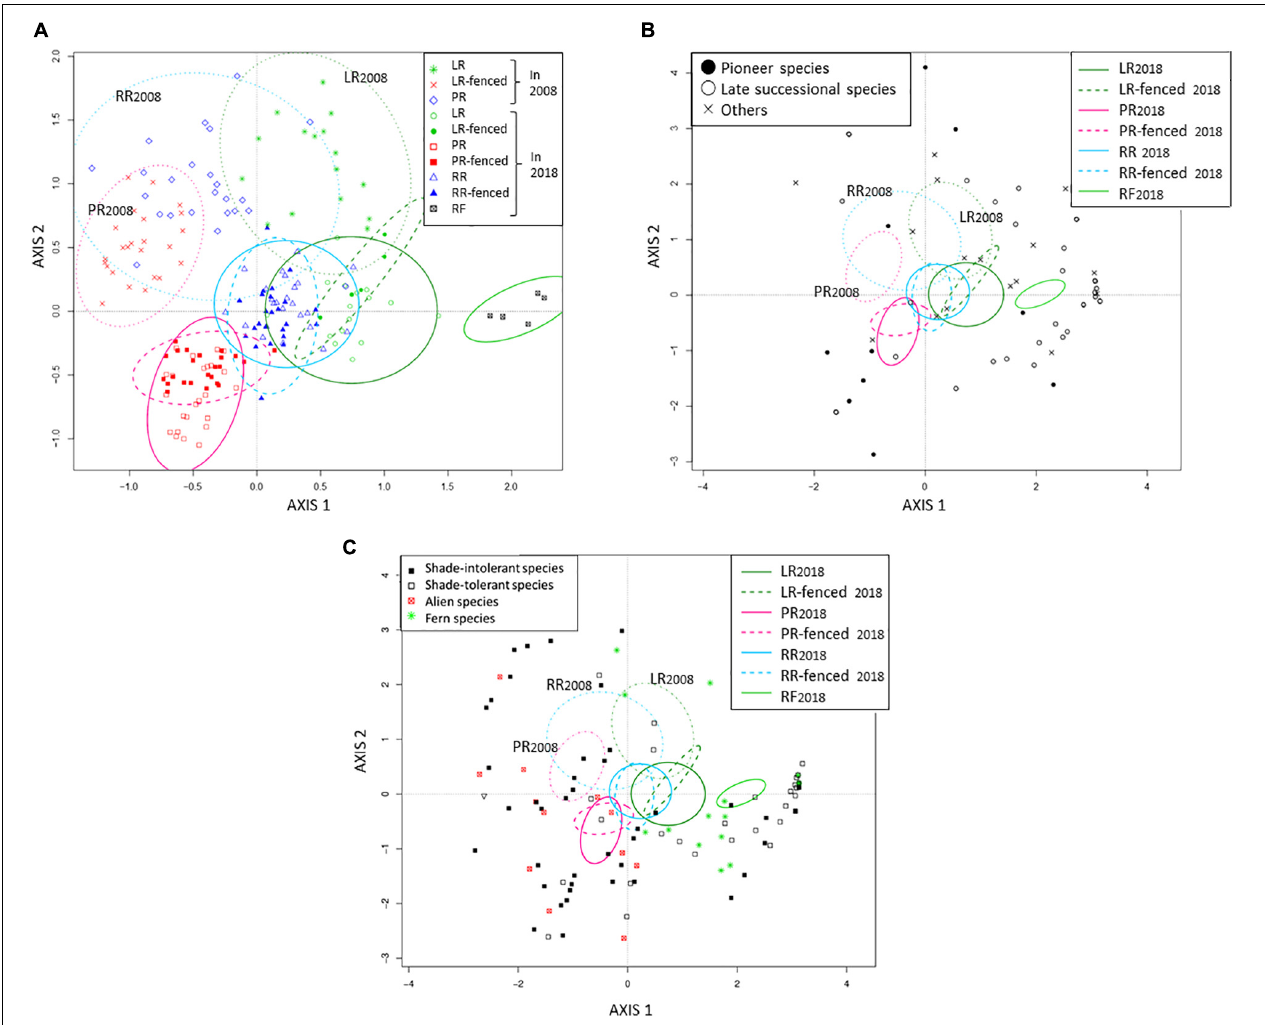
FIGURE 4 | Biplot of species composition according to DCA. (A) Quadrat distribution, (B) Woody species with quadrat distribution, (C) Herbaceous species with quadrat distribution. LR, legacy retention; LR-fenced, LR enclosed by a deer fence; RR, residual rows; RR-fenced, RR enclosed by a deer fence; PR, planting rows; PR-fenced, PR enclosed by a deer fence; and RF, mature, natural mixed forest (reference site). The subscripts 2008 and 2018 indicate the year of the investigation. The 90% confidence interval of the quadrat distribution for each treatment is shown as an